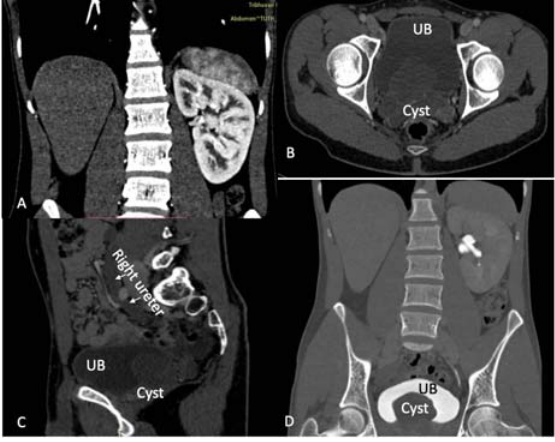
Figure 2. CT Urography images – Empty right renal fossa with normal appearing left kidney (A); Slightly hyperdense (compared to the urinary bladder retrovesical cyst predominatly on right side, protruding into urinary bladder (B); Dilated right ureter opening into the cystic structure (C); Normally excreting left kidney with (cid:81)(cid:82)(cid:85)(cid:80)(cid:68)(cid:79)(cid:79)(cid:92)(cid:3) (cid:82)(cid:83)(cid:68)(cid:70)(cid:76)(cid:191)(cid:72)(cid:71)(cid:3) (cid:79)(cid:72)(cid:73)(cid:87)(cid:3) (cid:71)(cid:76)(cid:86)(cid:87)(cid:68)(cid:79)(cid:3) (cid:88)(cid:85)(cid:72)(cid:87)(cid:72)(cid:85)(cid:15)(cid:3) (cid:81)(cid:82)(cid:81)(cid:16)(cid:82)(cid:83)(cid:68)(cid:70)(cid:76)(cid:191)(cid:70)(cid:68)(cid:87)(cid:76)(cid:82)(cid:81)(cid:3) (cid:82)(cid:73)(cid:3) dilated right ureter and contrast in the urinary bladder and (cid:70)(cid:92)(cid:86)(cid:87)(cid:76)(cid:70)(cid:3)(cid:86)(cid:87)(cid:85)(cid:88)(cid:70)(cid:87)(cid:88)(cid:85)(cid:72)(cid:3)(cid:68)(cid:83)(cid:83)(cid:72)(cid:68)(cid:85)(cid:76)(cid:81)(cid:74)(cid:3)(cid:68)(cid:86)(cid:3)(cid:191)(cid:79)(cid:79)(cid:76)(cid:81)(cid:74)(cid:3)(cid:71)(cid:72)(cid:73)(cid:72)(cid:70)(cid:87)(cid:3)(cid:90)(cid:76)(cid:87)(cid:75)(cid:76)(cid:81)(cid:3)(cid:87)(cid:75)(cid:72)(cid:3)(cid:88)(cid:85)(cid:76)(cid:81)(cid:68)(cid:85)(cid:92)(cid:3) bladder (D).